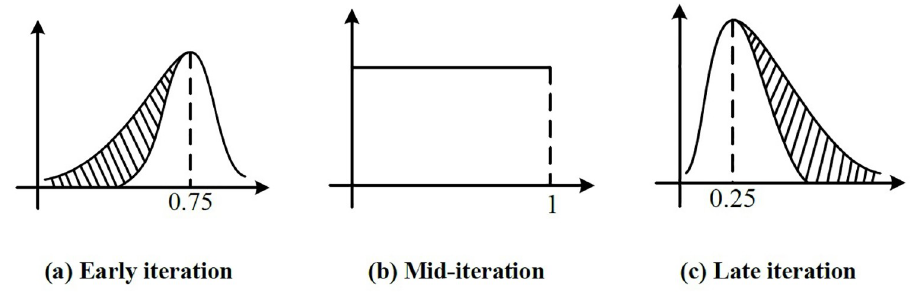
Fig 2. Probability generation of whale social behavior. (a) Early iteration, b) Mid-iteration, c) Late iteration.